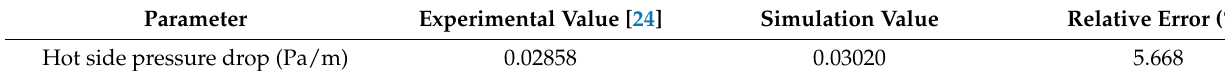
Figure 6. Grid independence for PCHE. Table 2. Comparison of simulation and experimental results.